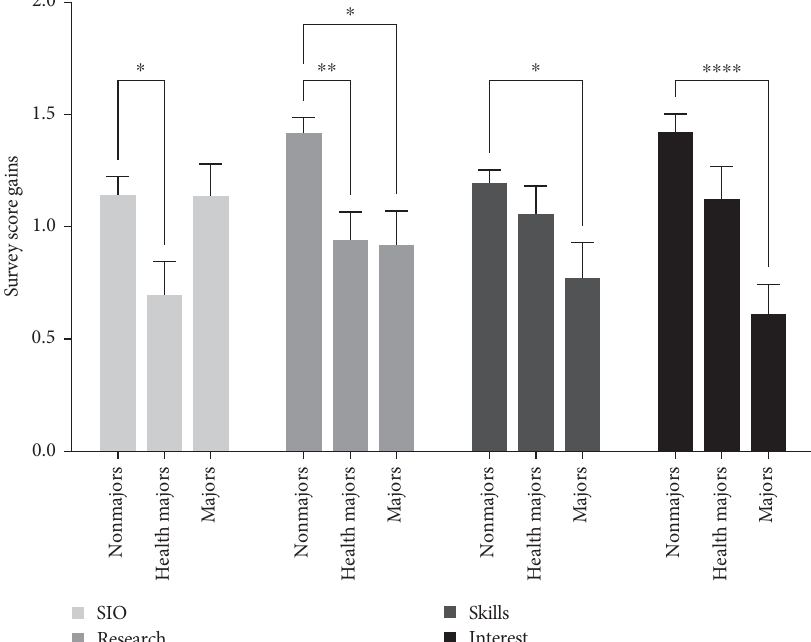
F IGURE 3: Survey score gains (mean and SEM) by themes and majors. Signi fi cant differences were observed for SIO knowledge between nonmajors and health majors ( p ¼ 0 : 0177), for Research between nonmajors and health majors ( p ¼ 0 : 0095) and nonmajors and majors ( p ¼ 0 : 0109), for Skills between nonmajors and majors ( p ¼ 0 : 0417), and for Interest between nonmajors and majors ( p < 0 : 0001). ∗ p ≤ 0 : 05, ∗∗ p ≤ 0 : 01, and ∗∗∗ p ≤ 0 :